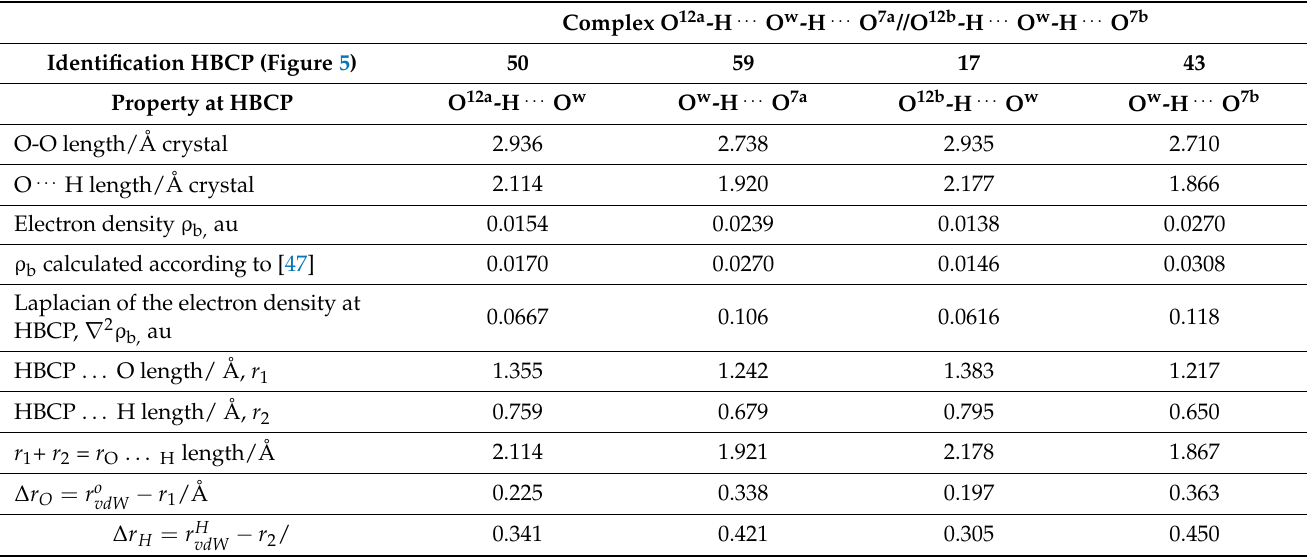
Table 1. Lengths involved in the formation of hydrogen bonds were determined from the crystal structure and calculated along with electron density and Laplacian